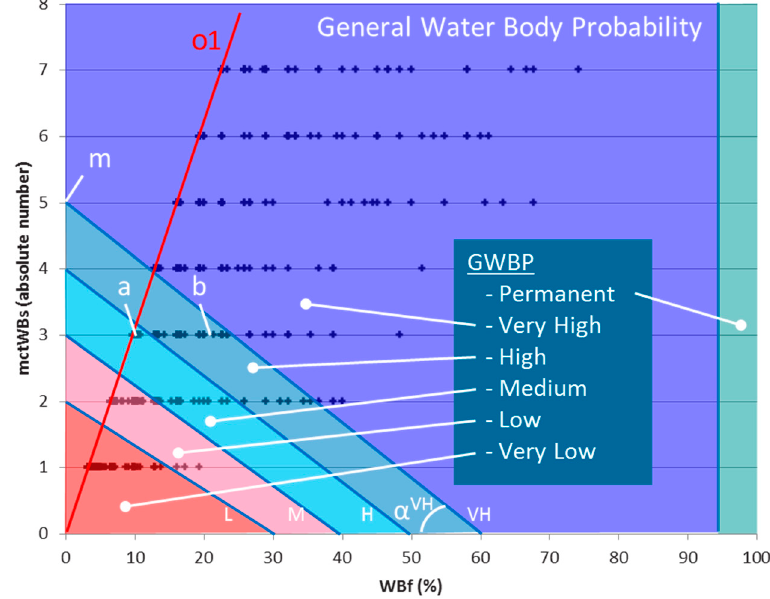
Figure 7. Example of a 2D scatter plot of the WB frequency ( WBf ) and the number of continuous temporal WB observations ( mctWBs ). The plus symbols belong to pixels of detected WBs for the Rift Valley test area calculated for the 31 available dekads. The Water Body Occurrence threshold levels are indicated by the different colored areas.